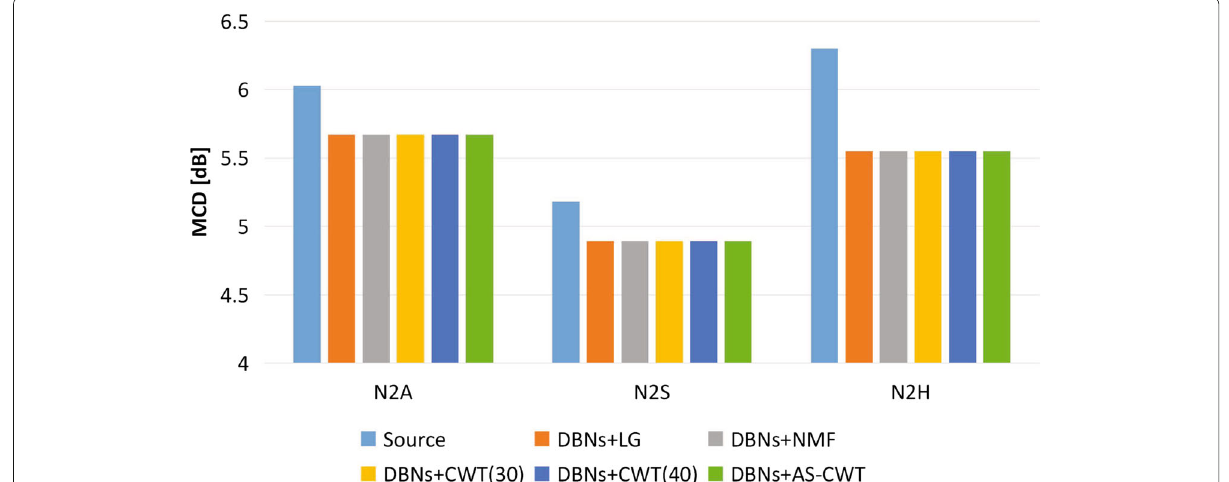
Fig. 11 Mel-cepstral distortion evaluation of spectral features conversion from neutral to emotional